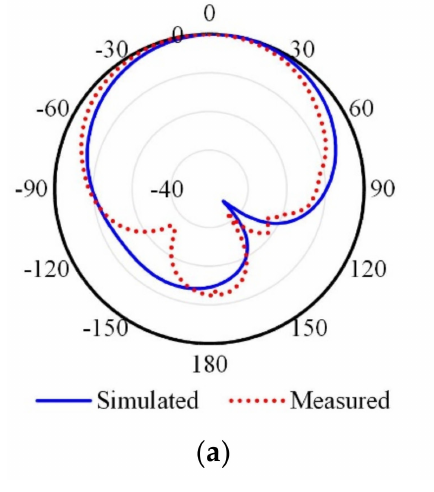
Figure 15. Radiation patterns of the proposed MIMO antenna in the xz-plane, ( a ) co-polarized and ( b )